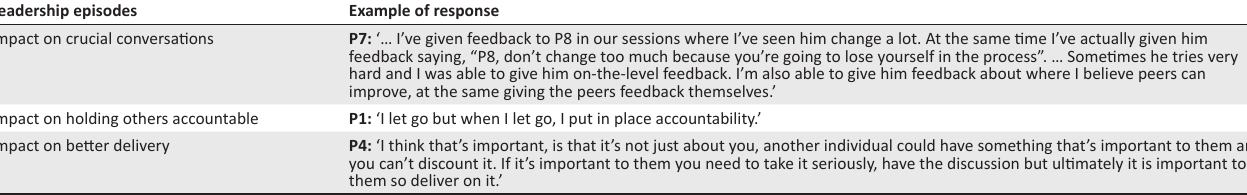
TABLE 3: Examples of leadership episodes that tested or further developed authentic leadership. Leadership